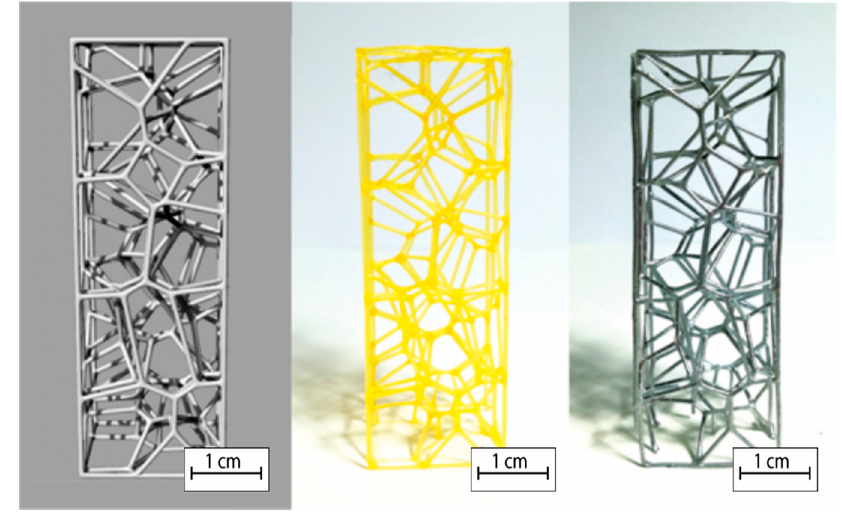
Figure 4. Comparison between CAD model, printed, and specimen obtained from foundry.